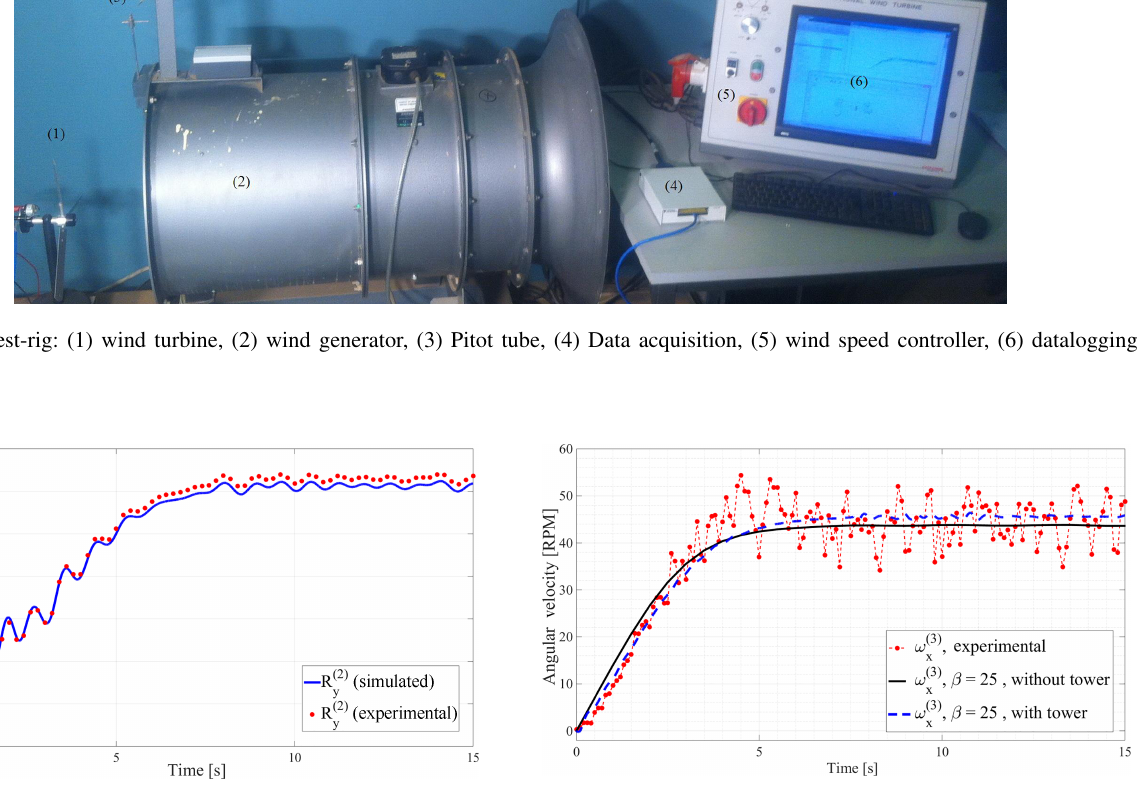
Figure 7. Transverse displacement of the Nacelle at β = 25 ◦ .